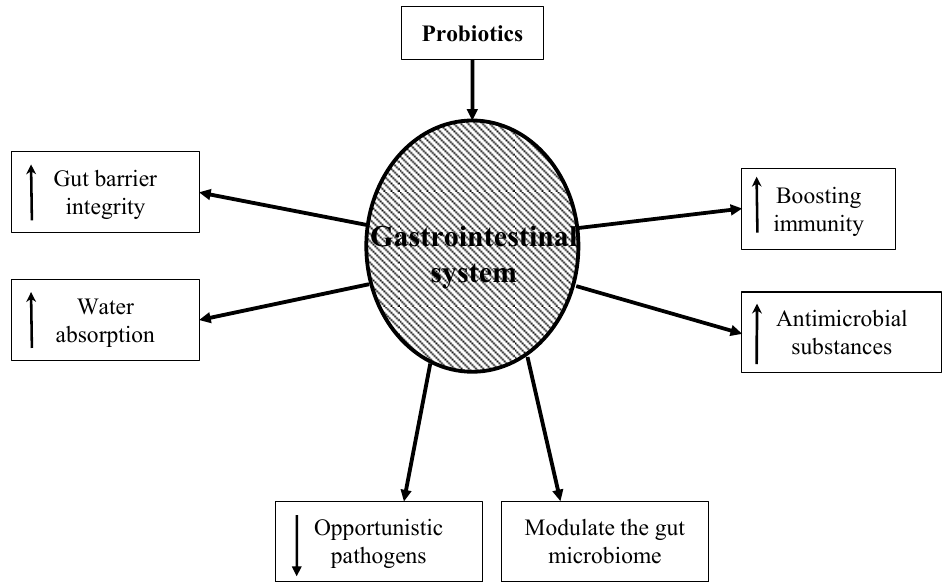
Figure 2. Hypothesized role of probiotics in the treatment of AAD. Upward and downward arrows inside the word boxes indicate increase and decrease, respectively.